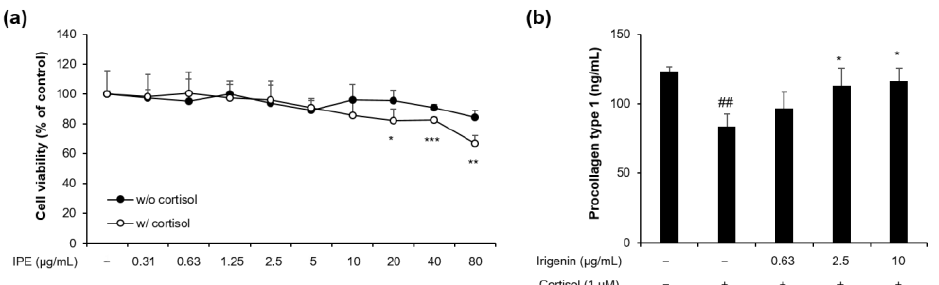
Figure 6. Effects of irigenin on the viability of HDFs with or without cortisol and on procollagen type 1 in cortisol-exposed HDFs. ( a ) The cells were treated with irigenin at various concentrations from 0.0315 to 80 μg/mL for 48 h with or without cortisol (1 μM). Cell viability was assessed using the CCK-8 assay. ( b ) The cells were pretreated with irigenin (0.63, 2.5, and 10 μg/mL) for 1 h and, then, exposed to cortisol (1 µM) for 48 h. ELISA of procollagen type 1 in the culture supernatant of HDFs. ## p < 0.01 compared to the control not exposed to cortisol; * p < 0.05, ** p < 0.01, *** p < 0.001 compared to the cortisol-exposed